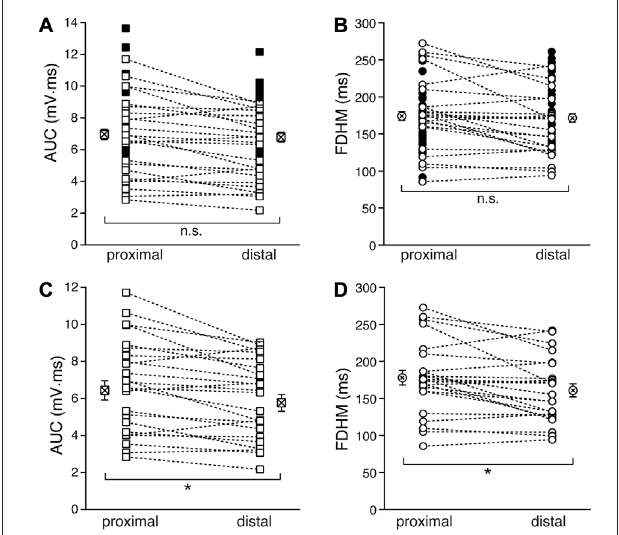
FIGURE 2 | Comparison of the burst features between proximal and distal stimulation. Top: the burst AUC (A) and the FDHM (B) appeared not to be significantly different between proximal and distal stimulations when the parameters for all the neurons with at least one stimulation location were compared (unpaired t -test). In these panels, open symbols connected by a dotted line represent values obtained from alternate stimulation of proximal and distal afferents to the same neuron, whereas filled symbols represent values obtained from neurons in which only one of the locations was stimulated. Bottom: when the comparisons were made by paired t -test in those neurons that were stimulated both proximally and distally, the AUC (C) and the FDHM (D) were significantly larger for bursts evoked by proximal stimulation than distal. Asterisks indicate significant